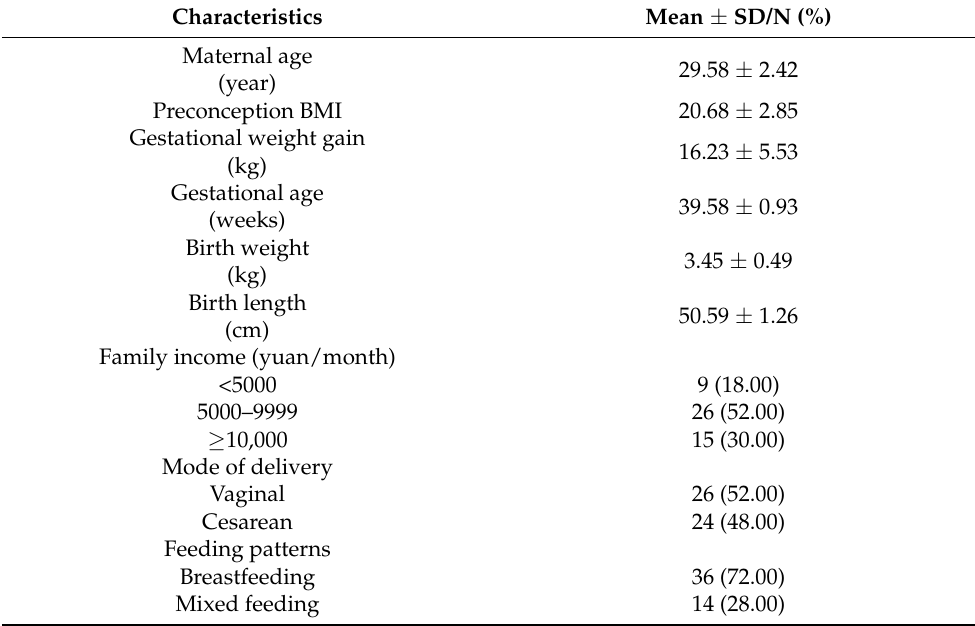
Table 2. Maternal and infant demographics of the